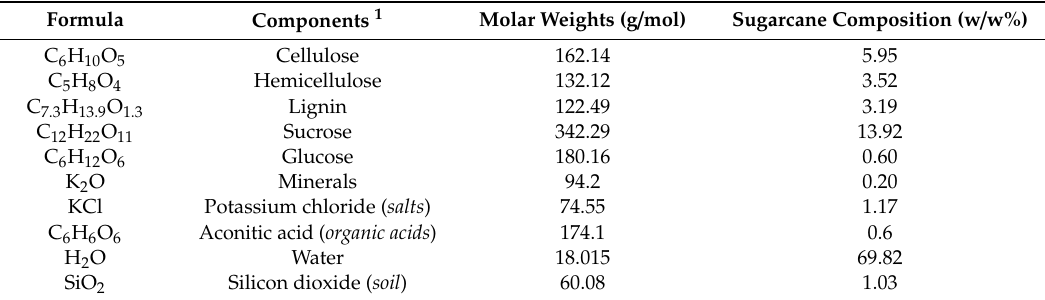
Table A1. Raw material